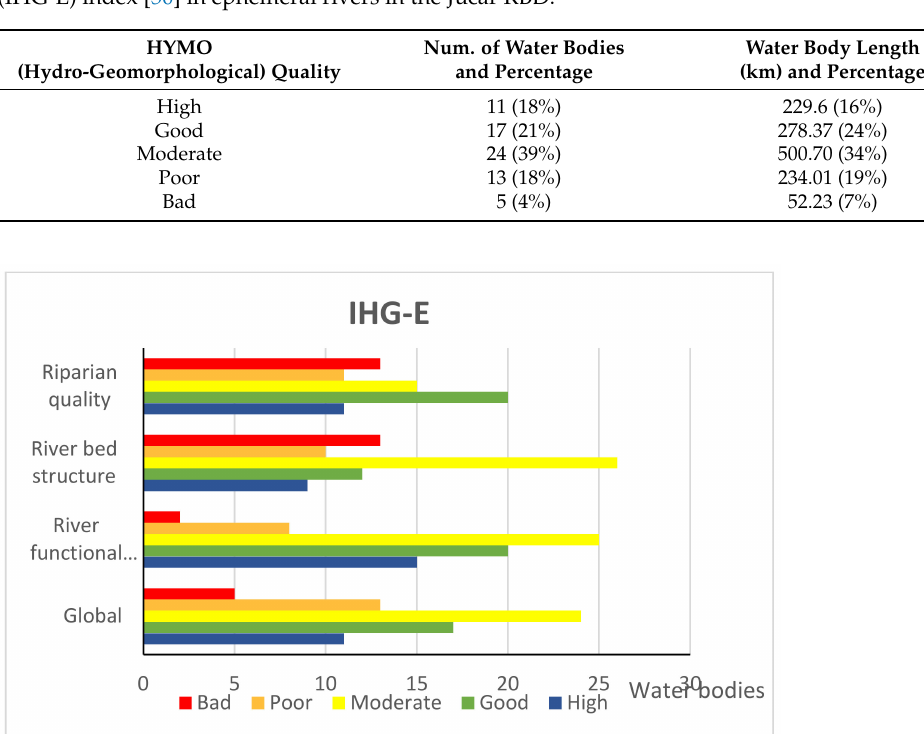
Table 2. Hydro-geomorphological quality results by using the hydro-geomorphological quality